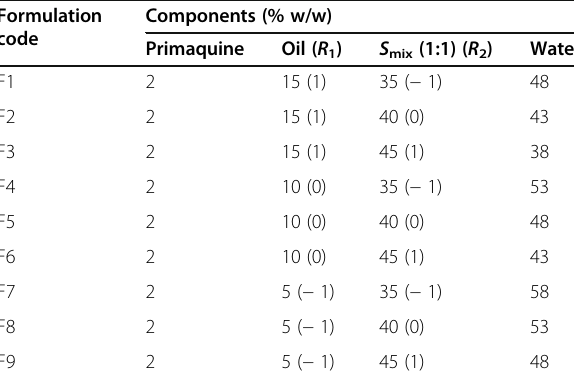
Table 5 Composition of primaquine loaded nanoemulsion Formulation